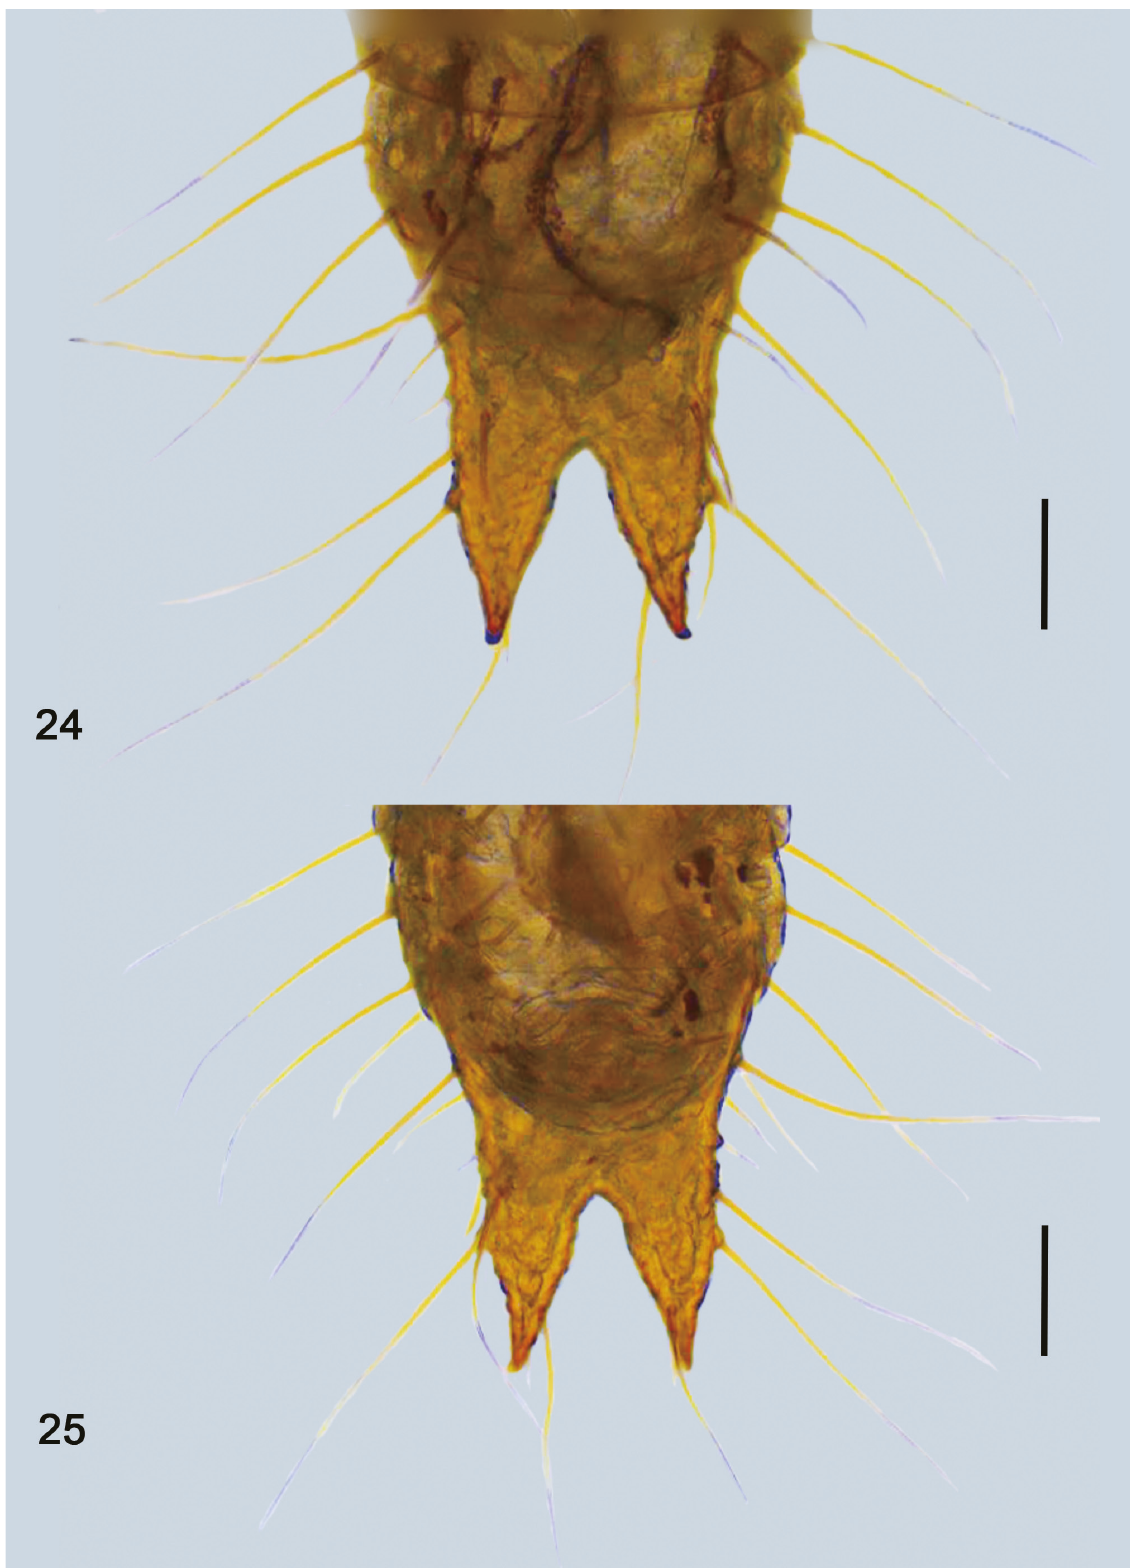
Figs 24–25. Abdominal segments 8–9 of first instar larva of Trictenotoma formosana Kriesche, 1919. 24 . Dorsal view. 25 . Ventral view. Scale bars: 0.1